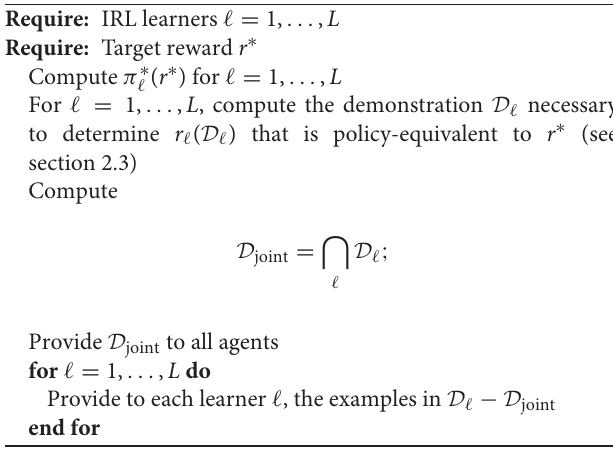
Algorithm 1 S PLIT T EACH : Exact teaching IRL